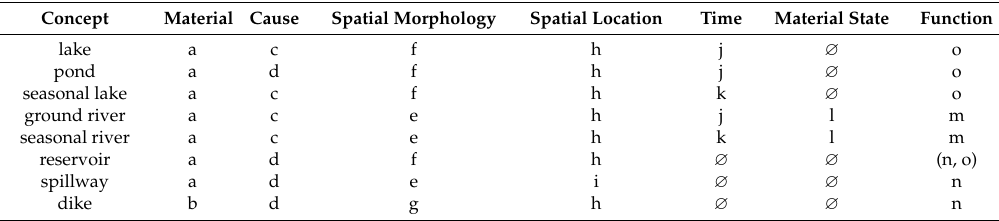
Table 1. Geo-concepts with attributes table.